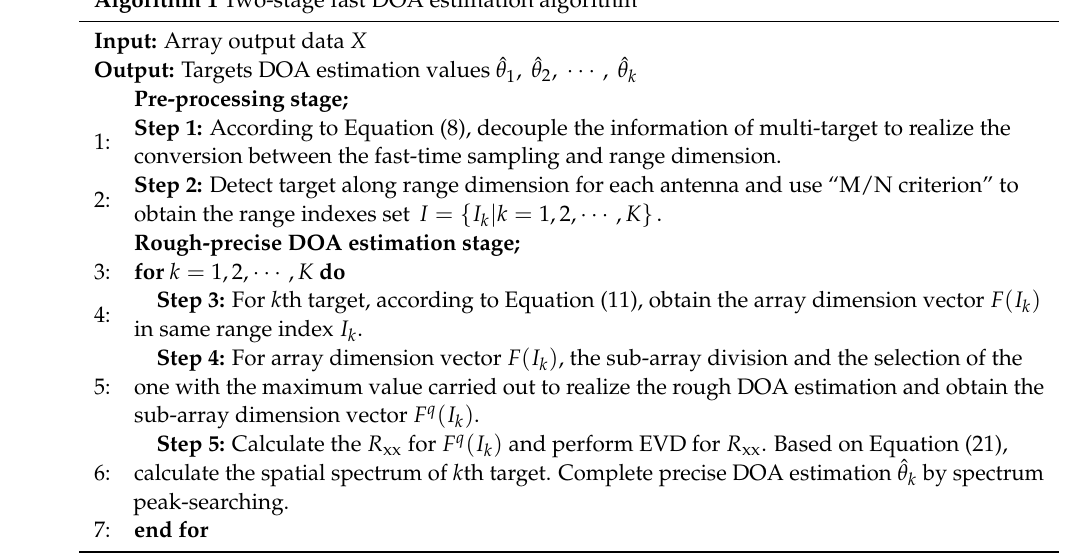
Algorithm 1 Two-stage fast DOA estimation algorithm